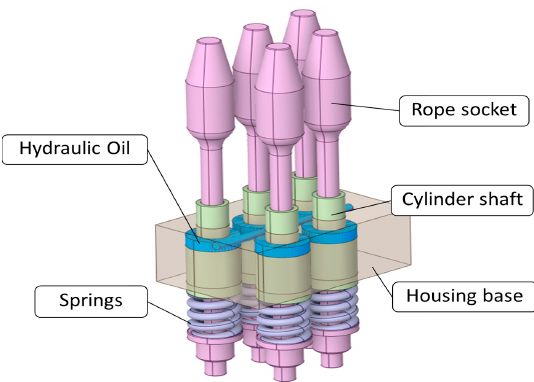
Figure 4. Three-dimensional modeling of the NABE-RE system. Table 2. Mechanical properties of the materials